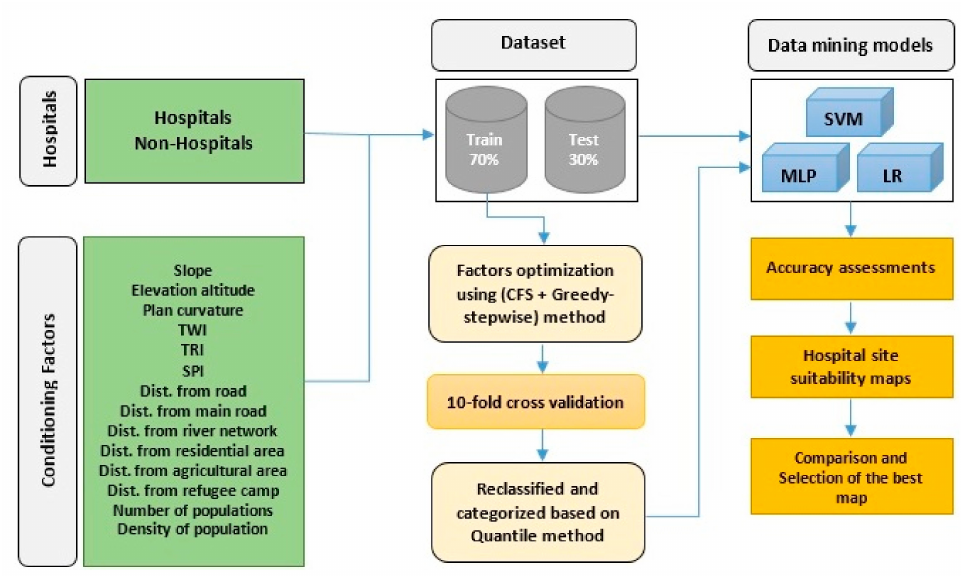
Figure 3. Overall methodological